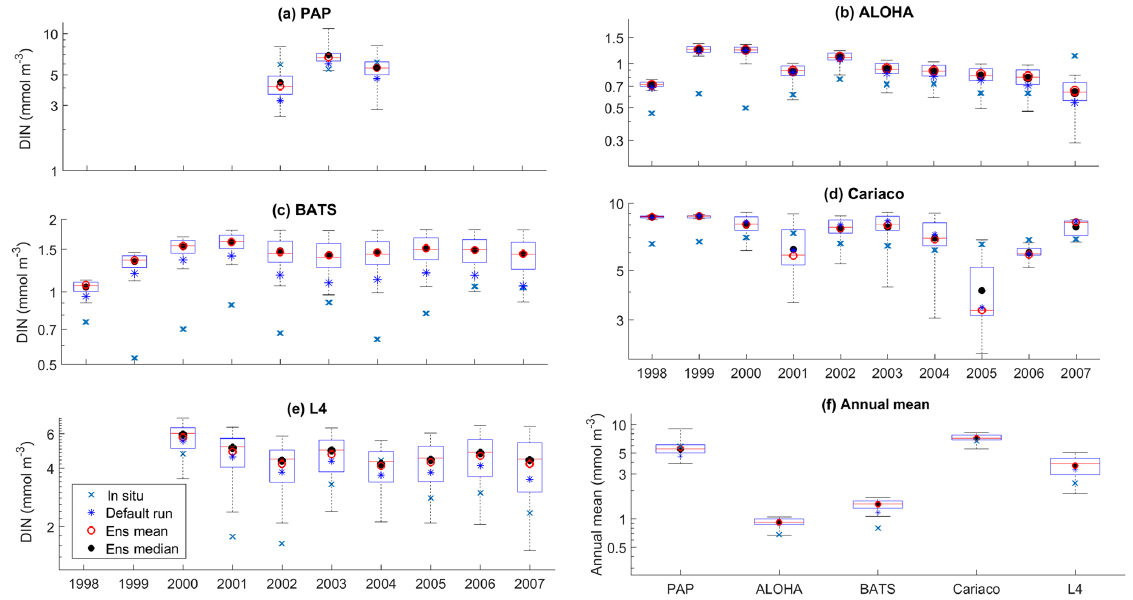
Figure 6. Inter-annual variability of DIN averaged over 200m, from all the study sites (a–e) and the annual mean (f) . Since the in situ data for PAP do not always cover the first 200m, the overall mean DIN concentration from all depths is used instead. For station L4, in situ DIN is only collected on the surface. The blue cross is the in situ observation; the red open circle, black dot, and blue stars are the ensemble mean, median, and default run respectively. The blue box is the 75th and 25th quartiles. The red line is the median, and the whiskers are the ensemble minimum and maximum of the averaged DIN. In station L4 and PAP data for DIN are only available from 2000 to 2007 and from 2002 to 2004 respectively.